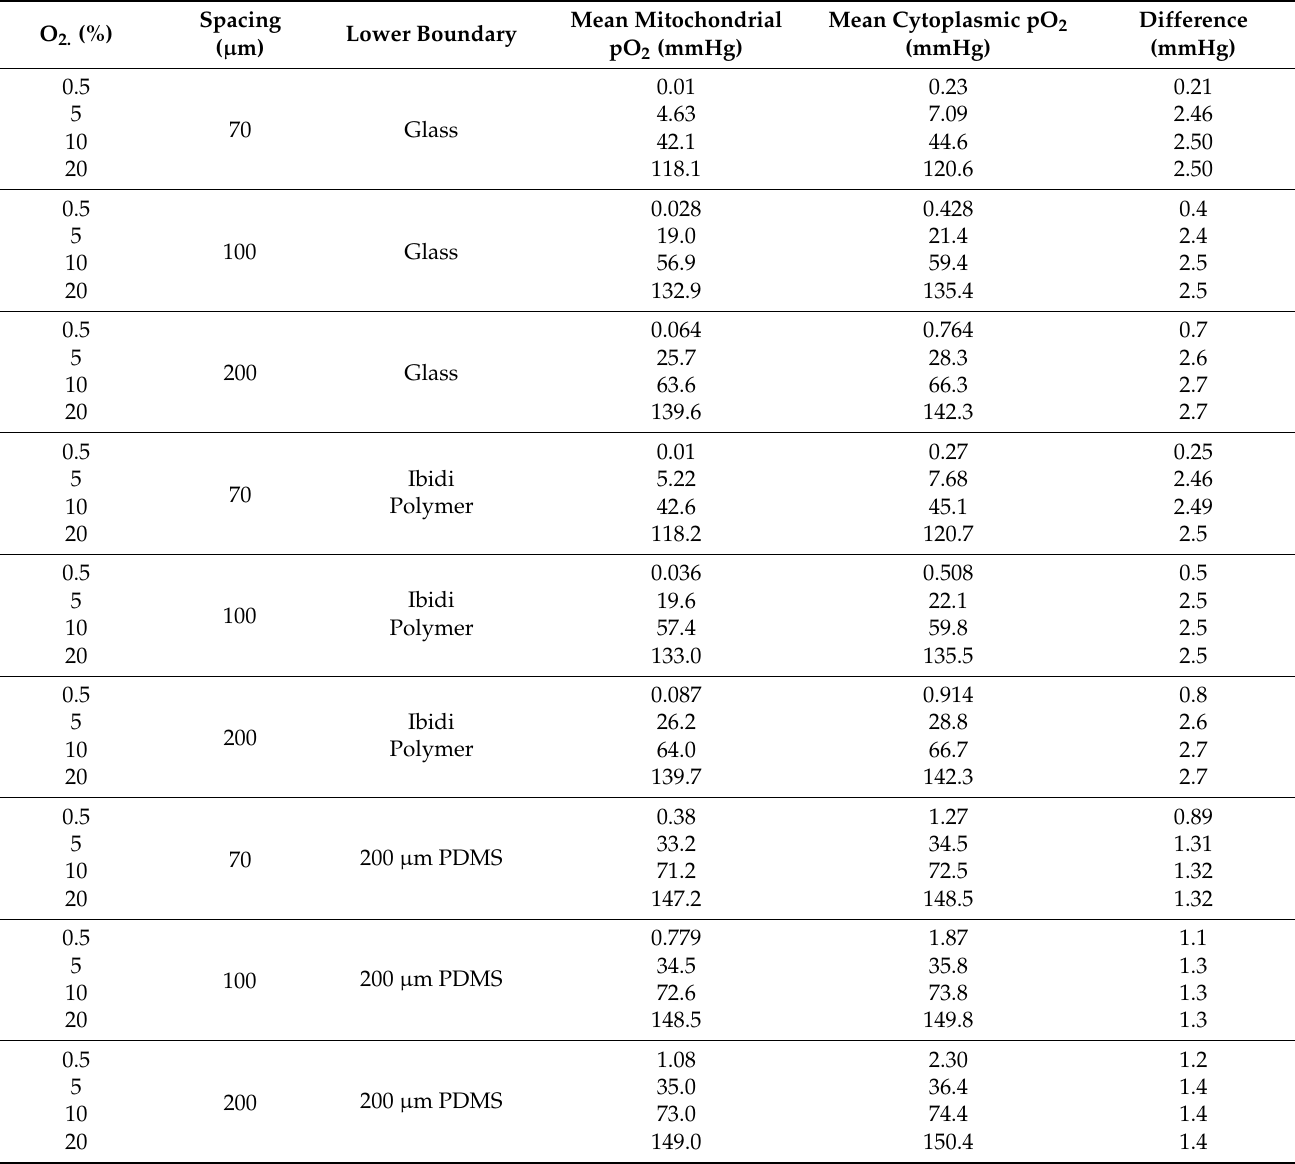
Table 2. Mean pO 2 in mitochondrial and cytosolic cellular compartments for models with different applied O 2 concentrations, cell spacings, and lower boundary conditions. Spacing describes the distance from the center of one cell to the center of the next cell in the square grid approximation of a